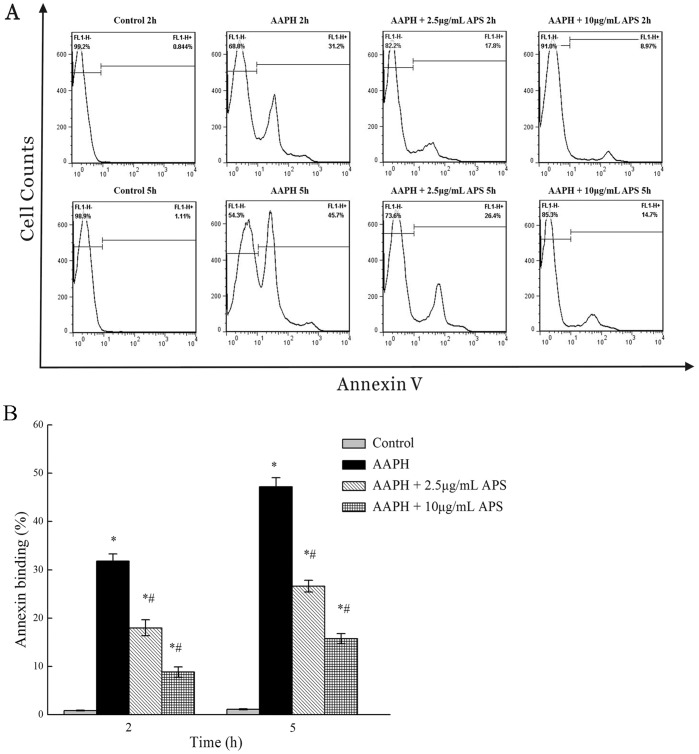
Effect of APS on annexin binding of erythrocytes following AAPH.A Representative original flow cytometry histograms of annexin binding of erythrocytes incubated in APS (2.5 and 10 µg/mL) or 75 mM AAPH for 2, 5 h. B Representative mean ± SEM of erythrocyte annexin binding after a 2, 5 h exposure to AAPH with and without APS. *indicates a significant difference from control group (P<0.05); # indicates a significant difference from AAPH group (P<0.05).